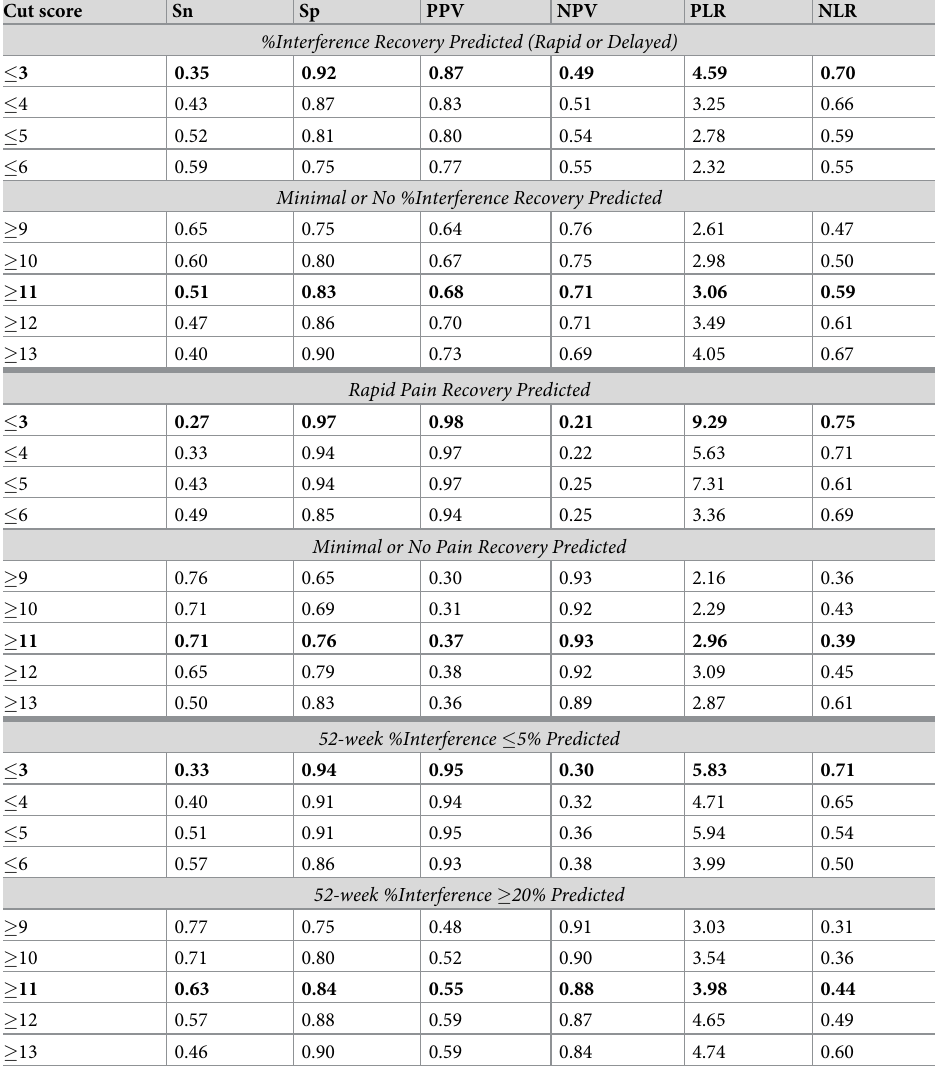
Table 5. A range of useful cut scores on the TIDS total for predicting interference recovery trajectories, Pain Severity recovery trajectories, and distal 12-month Interference